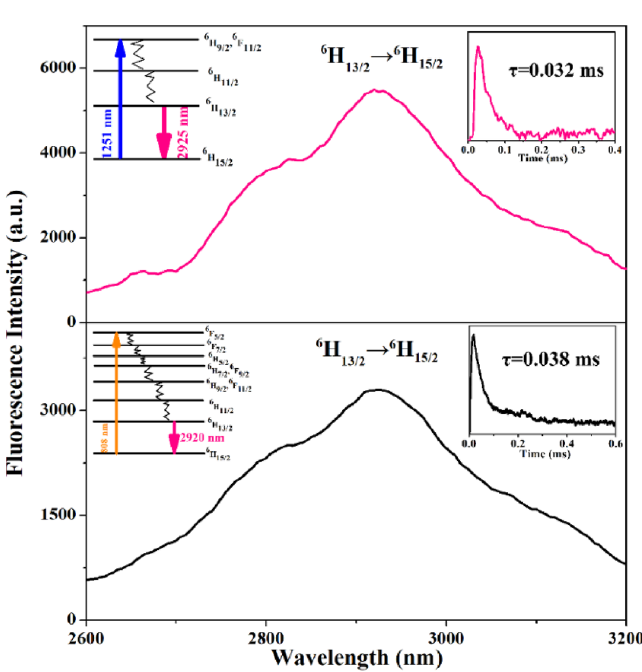
Figure 9. The MIR emission spectra and fluorescence decay curves of Dy 3+ : 6 H 13/2 in CYA crystal pumped by 1281 nm (upper panel) and 808 nm (lower